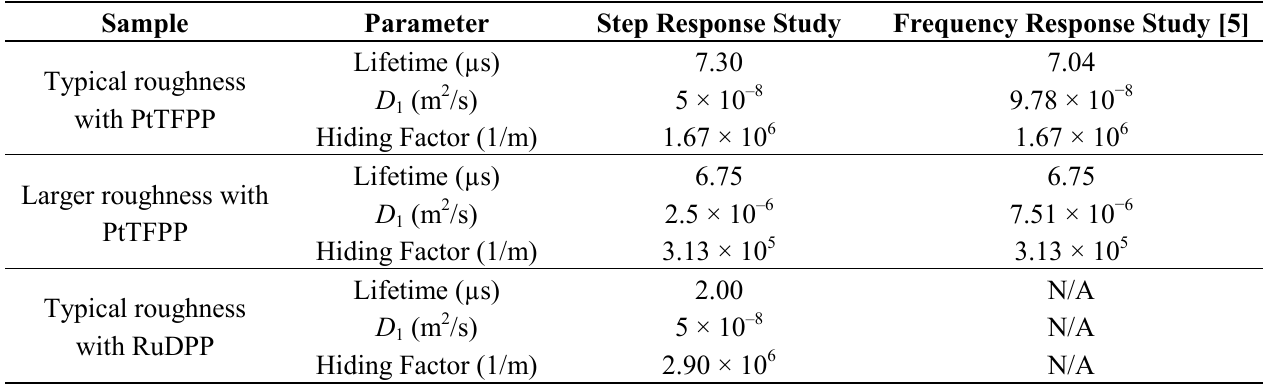
Figure 9. Measured and simulated intensity ( a ) and pressure ( b ) step response for different luminophores. Table 2. Model parameters for curve